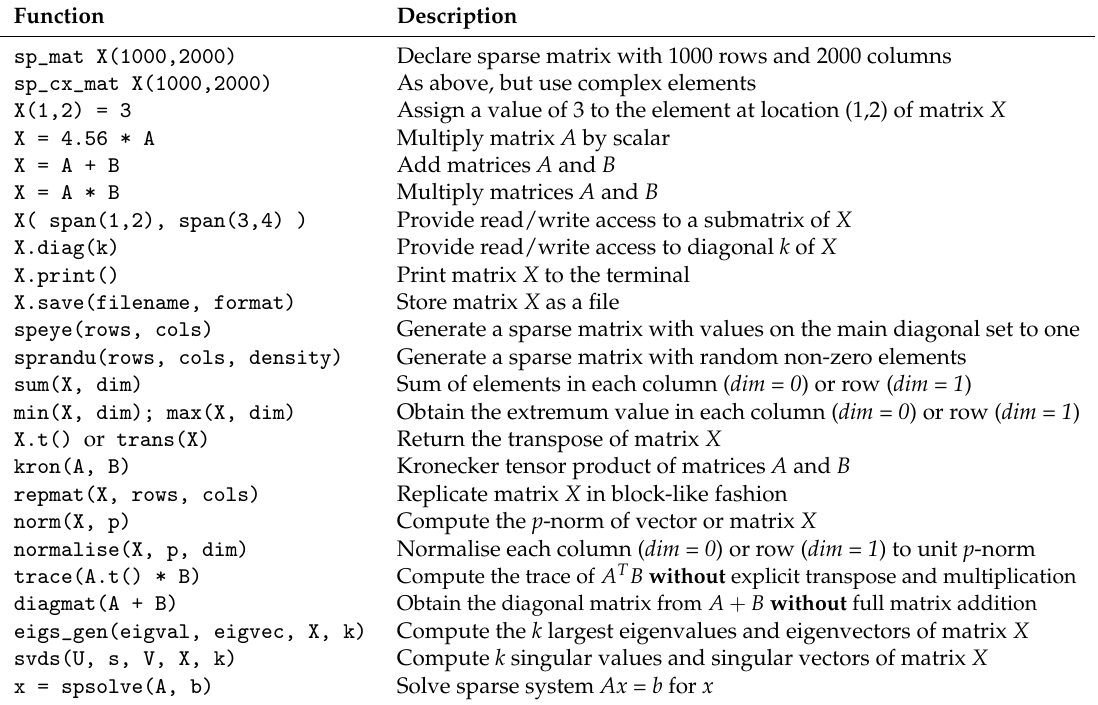
Figure 1. A small C++ program to demonstrate the usage of the sparse matrix class ( sp_mat ). Table 1. Subset of available functionality for the sparse matrix class, with brief descriptions. Optional additional arguments have been omitted for brevity. See http://arma.sourceforge.net/docs.html for more detailed